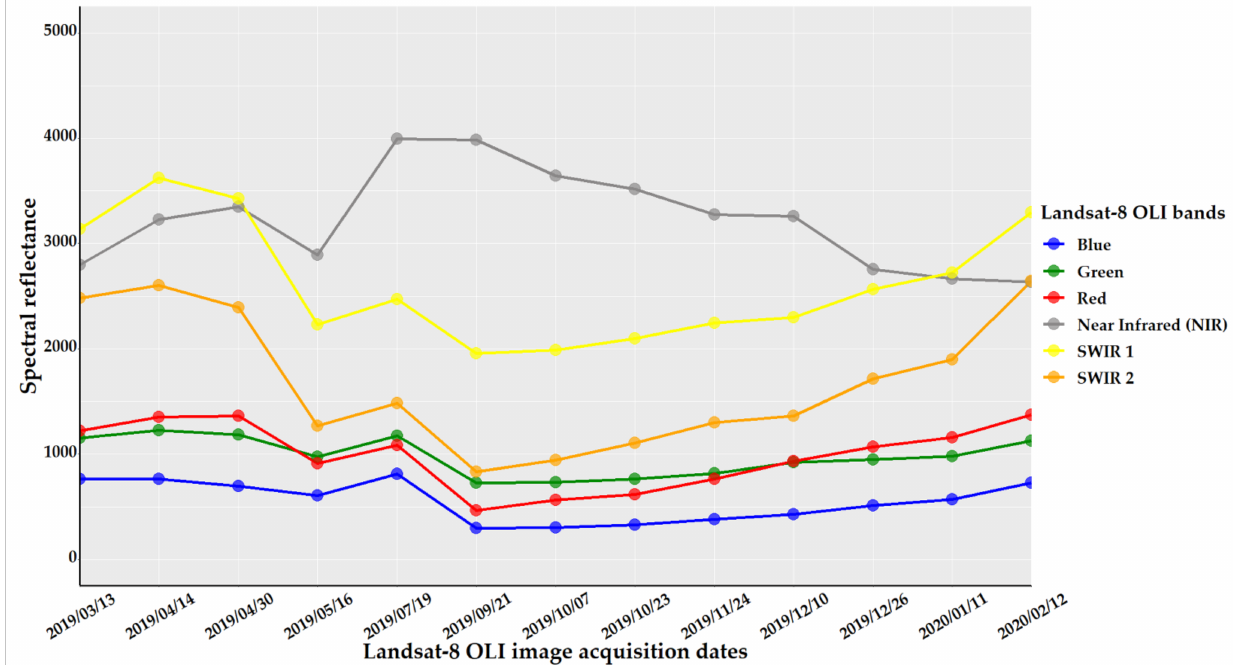
Figure 7. Spectral signature profiles of sugarcane crop in 2019/2020 from 25 field sampling points in Udon Thani province, Thailand. Average spectral reflectance values were extracted from Landsat-8 OLI images time series with blue (blue line), green (green line), red (red line), near-infrared (NIR) (gray line), shortwave infrared (SWIR 1) (yellow line), and SWIR 2 (orange